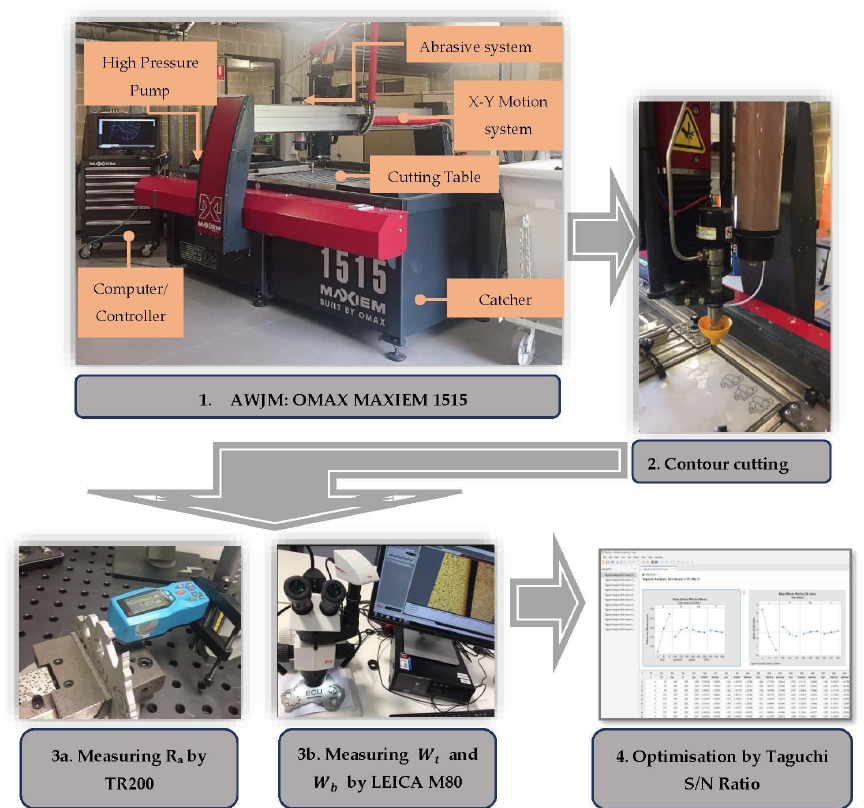
Figure 3. AWJM contour cutting experiment and analysis setup.